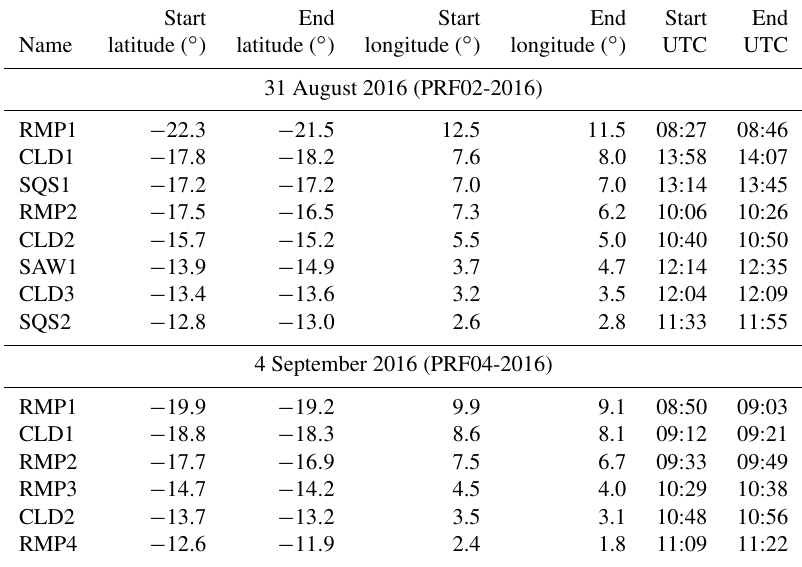
Figure 2. Scatterplot of observed N d against N d predicted from a regression using (a) all valid AC SO 4 , BC SO 4 , AC rBC, and BC rBC observations, (b) only SO 4 observations, (c) only rBC observations, (d) only BC observations, and (e) only AC observations. 31 August and 4 September flights are highlighted in red and blue, respectively. Dashed black lines show the one-to-one line. (f) Bar chart showing R 2 for all regressions. Table 2. Starting and ending latitude, longitude, and time for all the flight legs from the 31 August and 4 September cases used in Figs. 3, 4, and